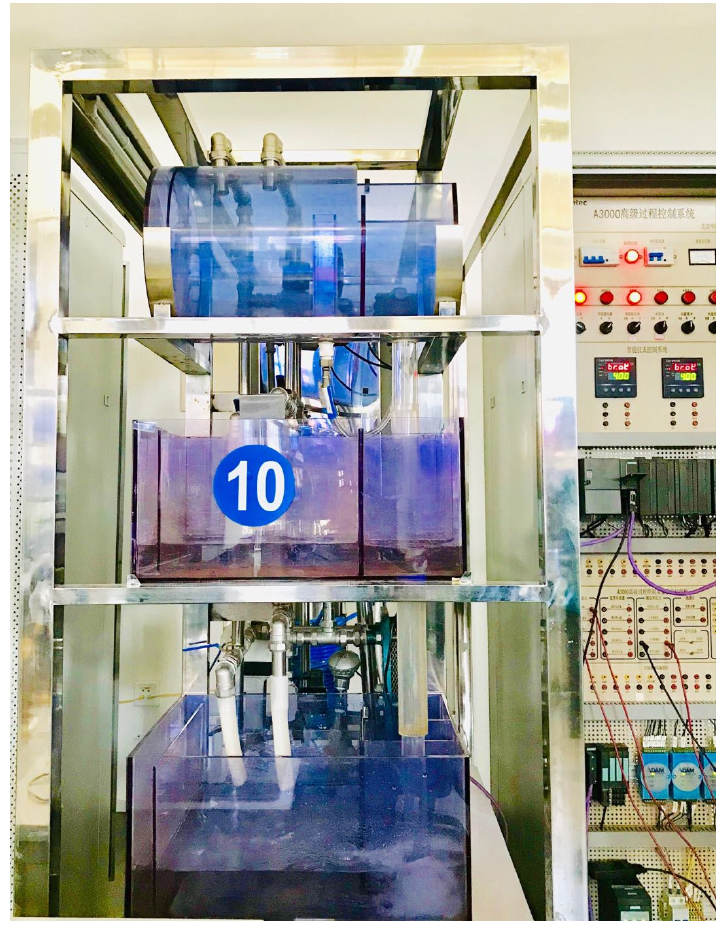
Figure 4. Water Tanks. Figure 4. Water